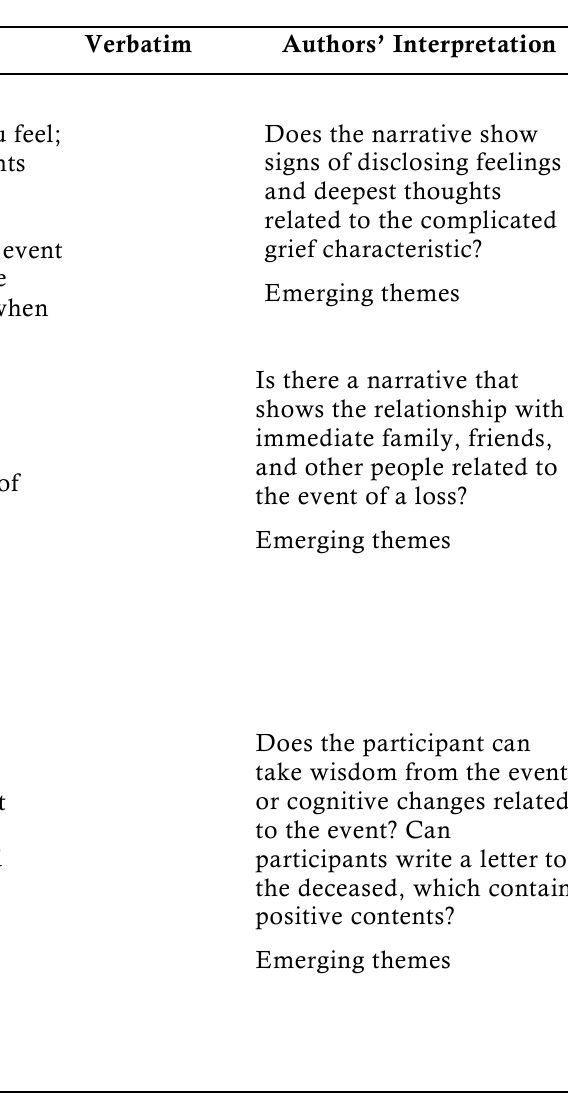
Table 3. Content analysis